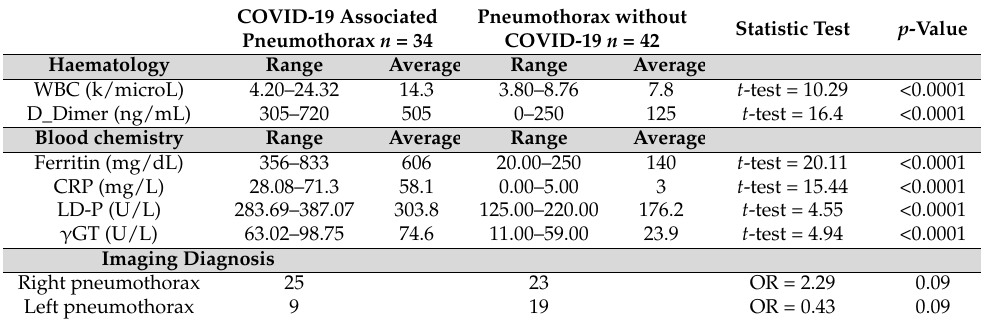
Table 3. Comparative values of laboratory findings and imaging diagnosis.